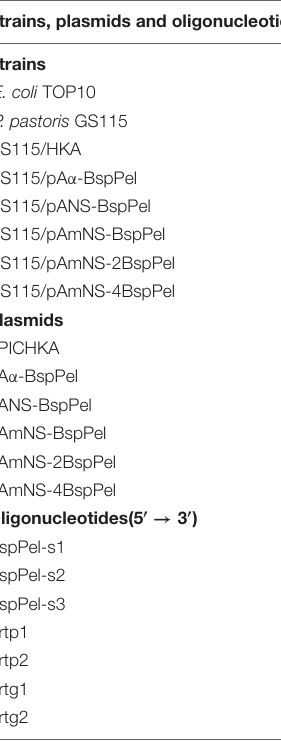
TABLE 1 | Strains, plasmids and oligonucleotides used in this study. Strains, plasmids and